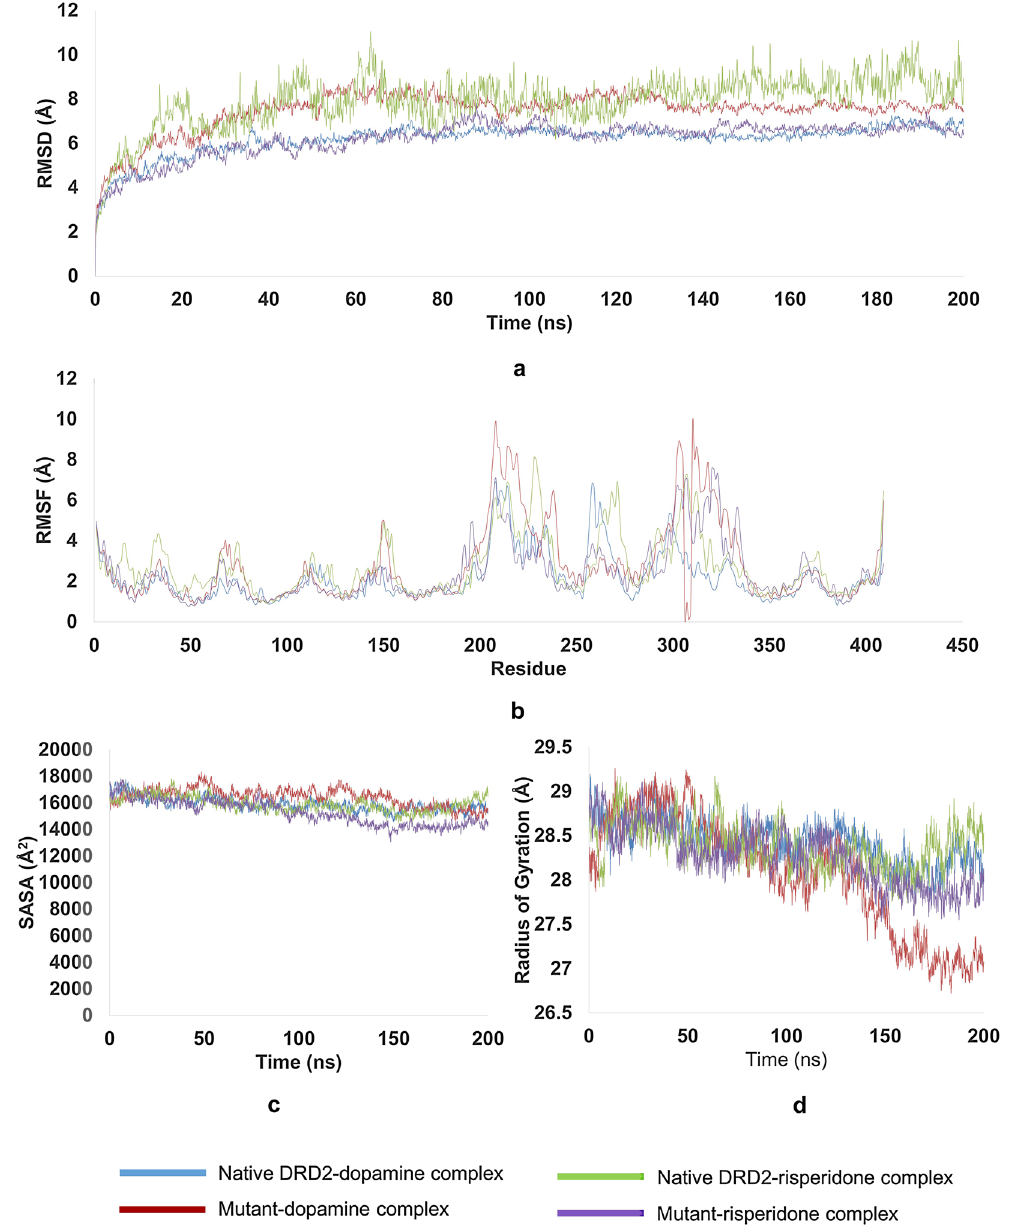
Figure 7. Results of 200 ns Molecular Dynamics Simulation by GROMACS software. Of the wild-type and F389V complexes with dopamine and risperidone: ( a ) RMSD values, ( b ) RMSF values, ( c ) SASA calculations and ( d ) Radius of